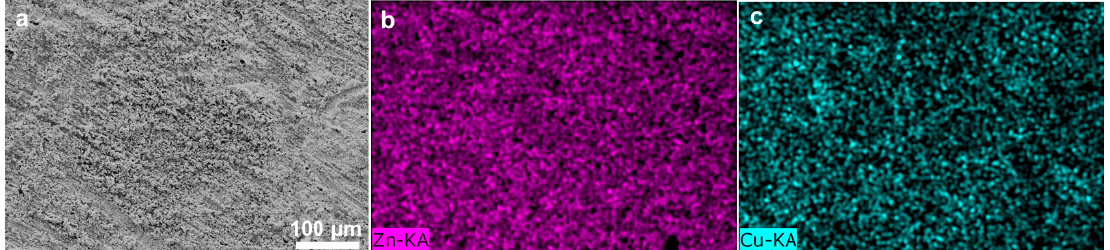
Figure 7. XRD pattern of Cu–Zn ( a ) after 1 cycle and ( b ) after 100 cycles at current density of 5 mA cm − 2 with a capacity of 1 mAh cm − 2 . ★ represents the XRD peak of CuZn 5 .